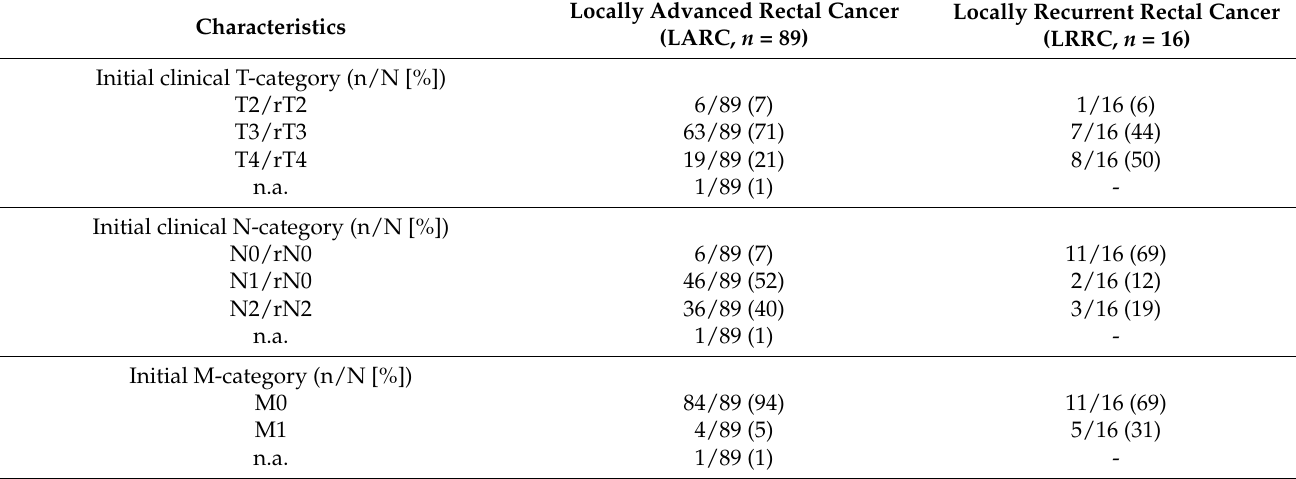
Table 1. Patient-, disease-, and treatment-related characteristics.